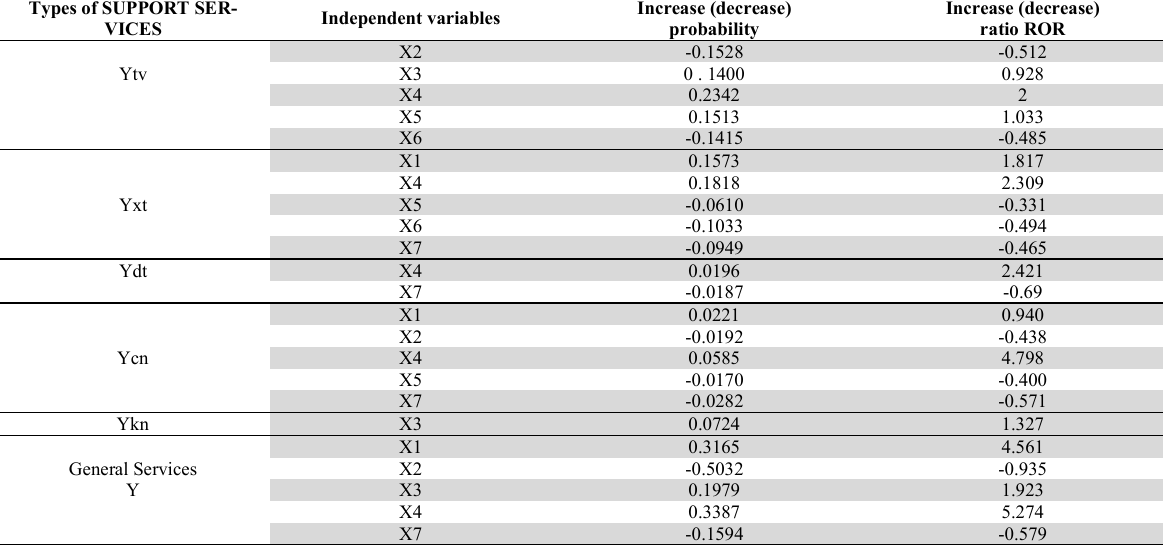
Impact of factors on the ability to use support services Types of SUPPORT SER-